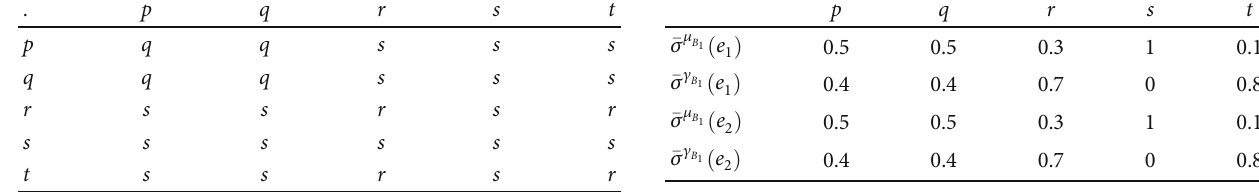
Table 7: Upper approximation of B